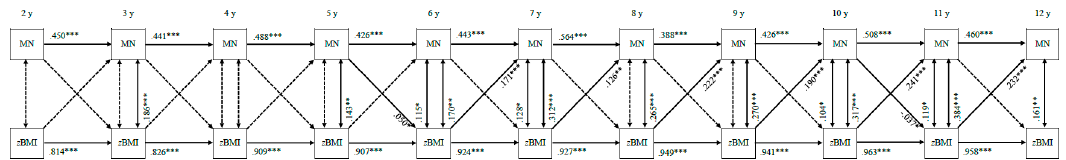
Figure 5. Bi-directional associations between monitoring and standardized child body mass index. MN—monitoring; z BMI—standardized body mass index. All associations are controlled for child sex and socio-economic status. Double-headed arrows display correlation coefficients between error terms; single-headed arrows display standardized regression coefficients; dotted arrows indicate non-significant associations. *** p < 0.001, ** p < 0.01, * p < 0.05.